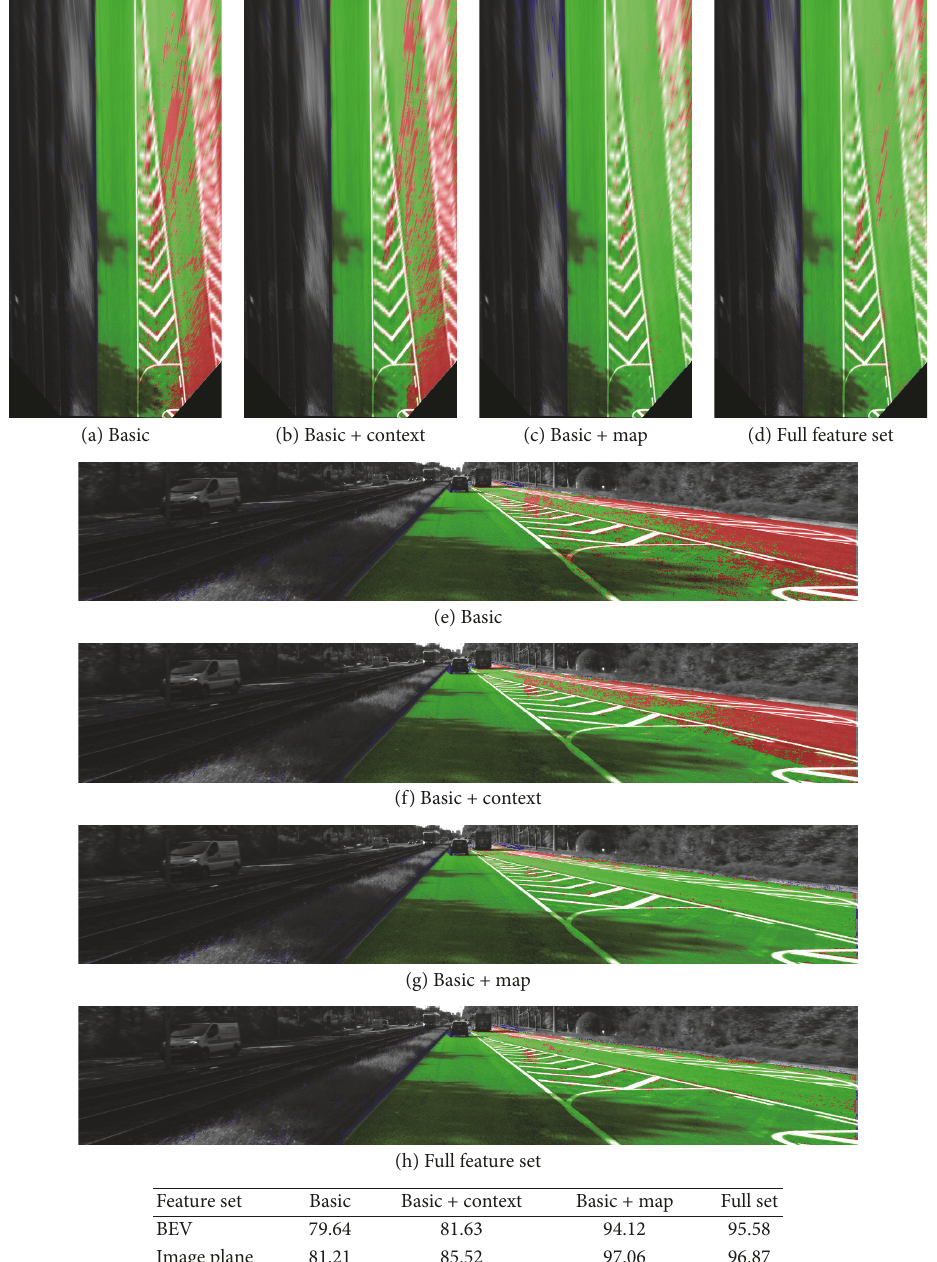
Figure 19: Results of unary terms in a specific UMM image. The map prior is very important because sometimes the context feature does not provide reliable information. The use of the map prior in scenarios with multiple marked lanes improves significantly the performance of the basic feature